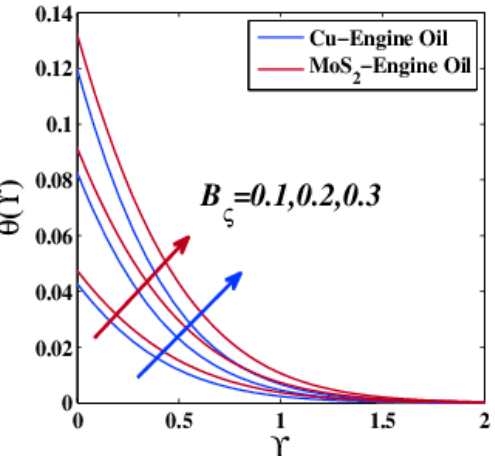
Figure 19. Temperature variation θ ( Y ) under the influence of B ς .